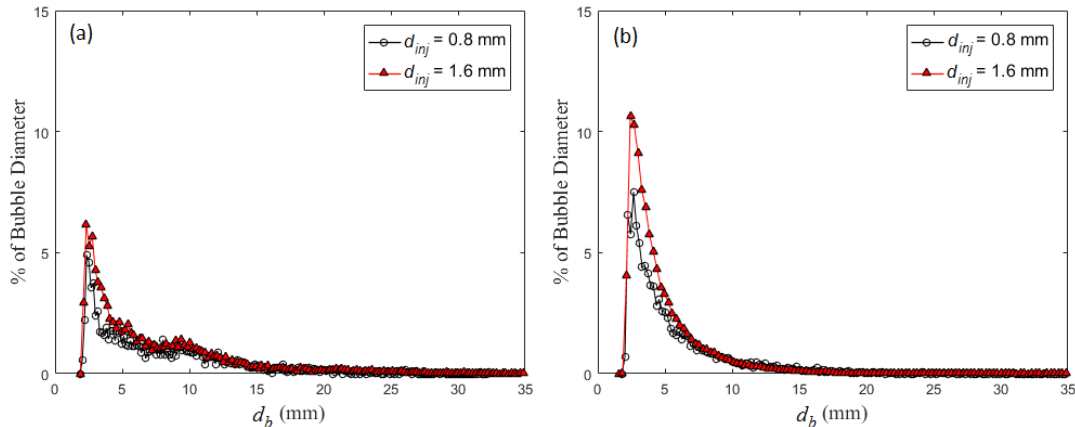
Figure 12. Bubble size PDF for the two injector tube diameters ( d inj = 0.8 or 1.6 mm) tested at ( a ) U sg = 6.9 mm/s and ( b ) U sg = 27.6 mm/s ( D = 102 mm; P m = 600 kPa; T c = 21 ± 1 °C). Table 1. The maximum measured bubbles size ( d max ) spanning the flow rates tested with both injector tube